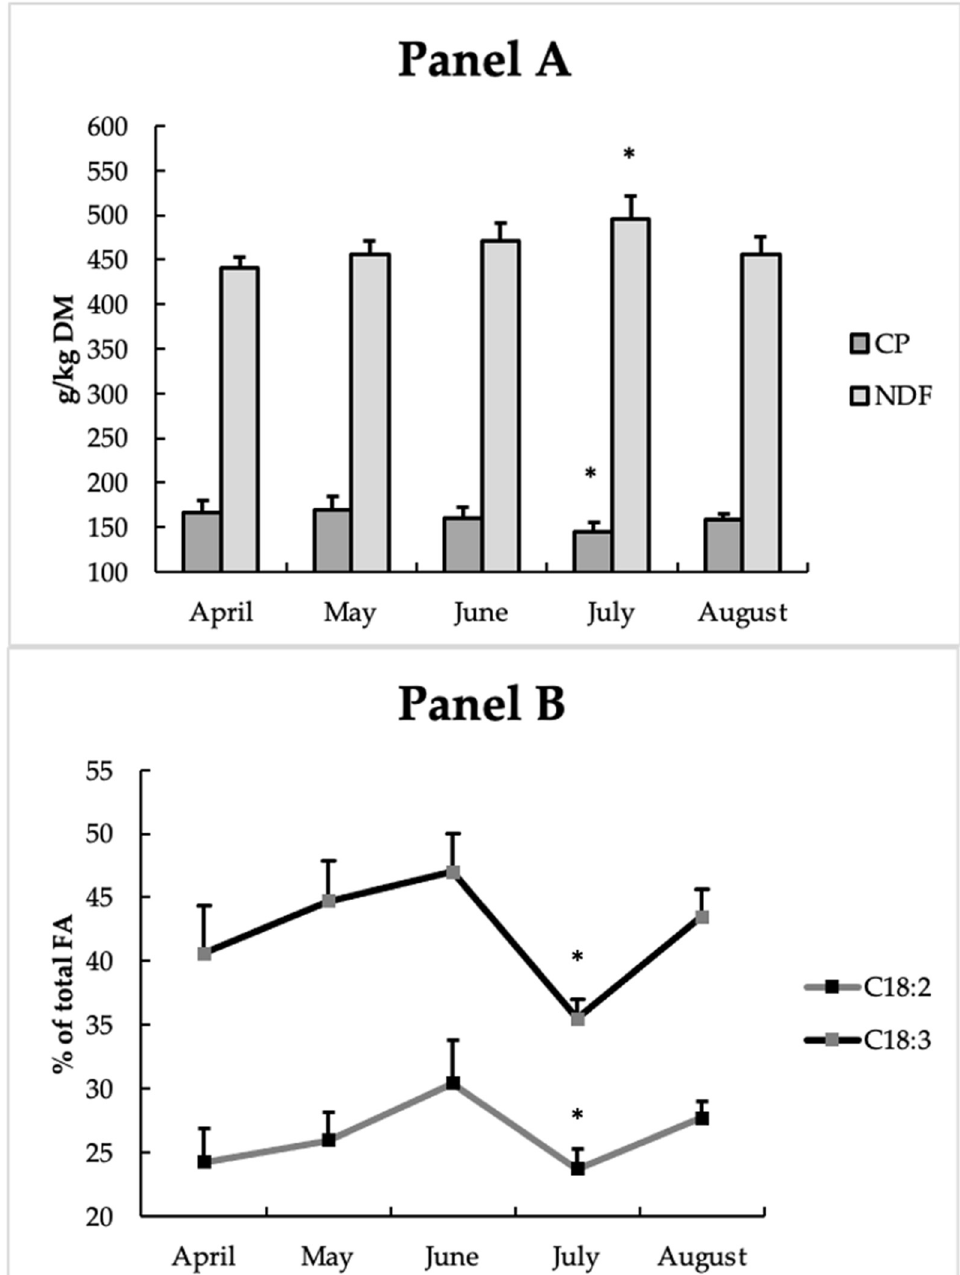
Figure 1. Pasture crude protein (CP) and neutral detergent fibre (NDF; Panel A ) and fatty acid profile ( Panel B ) during the experimental period (mean ± SD). FA: fatty acids; DM: dry matter. Pasture composition: Leguminosae (in a ratio of 60% Trifolium alexandrinum , Vicia spp.) and Graminae (in a ratio of 40% Bromus catharticus , Festuca arundinacea , Lolium perenne ). * p < 0.05.